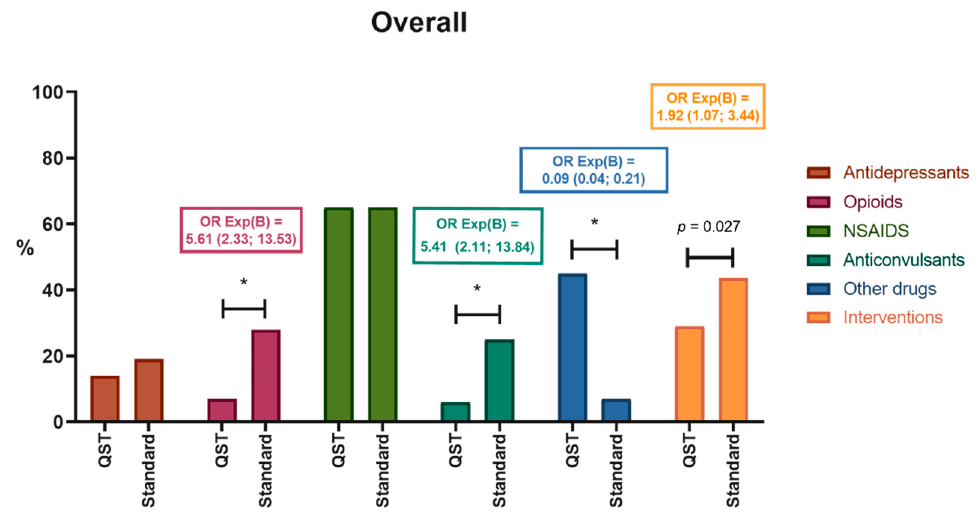
Figure 2. Medical treatment prescribed at the initial visit for the overall sample, comparing patients with standard assessment and QST/CPM assessment. * p < 0.008, using Bonferroni correction. Odds ratios (OR) are described.